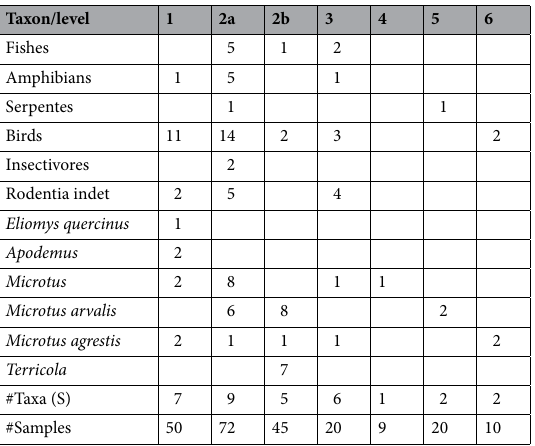
Table 3. Microfossil remains (NISP) identified in Peña Capón. “#Samples” refers to the number of plastic bags collected for the study. “#Taxa (S)” is the number of taxa identified in the total number of samples for each